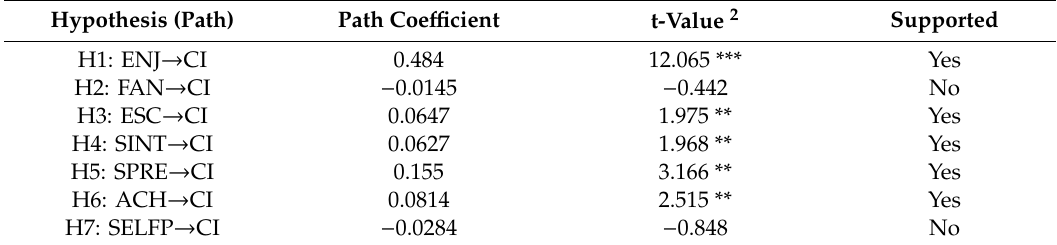
Table 5. Results of hypothesis